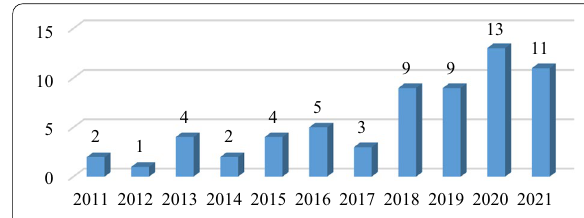
Fig. 4 Distribution of the articles by year ( N